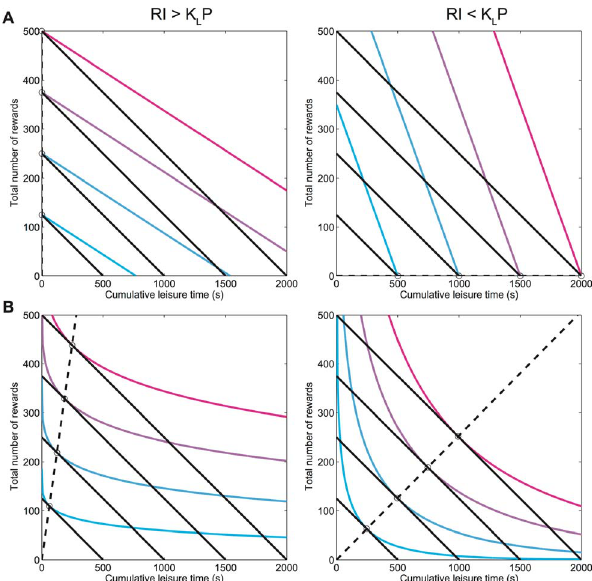
Figure 1. Indifference curves (ICs) of the labor supply theory model in Eq.(1). Left: Returns from work exceed those from leisure ( RI w K L P ) and right: vice versa ( RI v K L P ). Solid black lines show the budget constraint (BC): trial duration T is constant. Open circles show optimal combination of rewards and leisure for which macroscopic utility is maximised subject to BC. Dashed black lines denote the path through theoretically predicted optimal leisure and reward combina- tions as T is increased. A) perfect substitutability between rewards (work) and leisure ( s ~ 1 ). Optimal combination is when the subject works all the time and claims all rewards if RI w K L P , and engage in leisure all the time otherwise. B) imperfect substitutability (e.g. s ~ 0 : 25 ). Optimal combination comprises non-zero amounts of work and leisure.